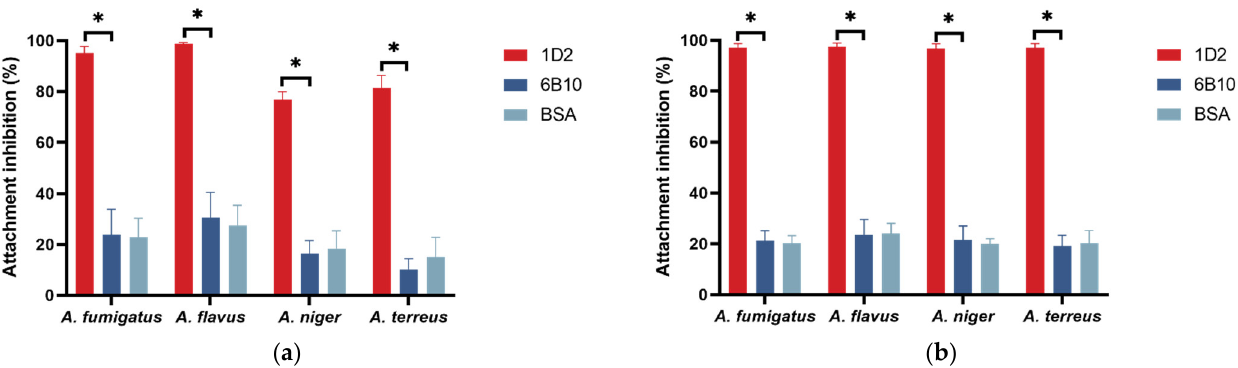
Figure 3. In vitro attachment inhibition of mAb 1D2 against A. fumigatus , A. flavus , A. niger and A. terreus . Compared to an unrelated mAb 6B10, mAb 1D2 (20 µg) showed statistically significant adhesive inhibition on A. fumigatus , A. flavus , A. niger and A. terreus (2 × 10 4 conidia), respectively, on untreated slide surfaces ( a ) and on fibronectin-treated slide surfaces ( b ). There was no difference between the mAb 6B10 control group and BSA control group for all Aspergillus species. *: p < 0.001 versus 6B10 group.